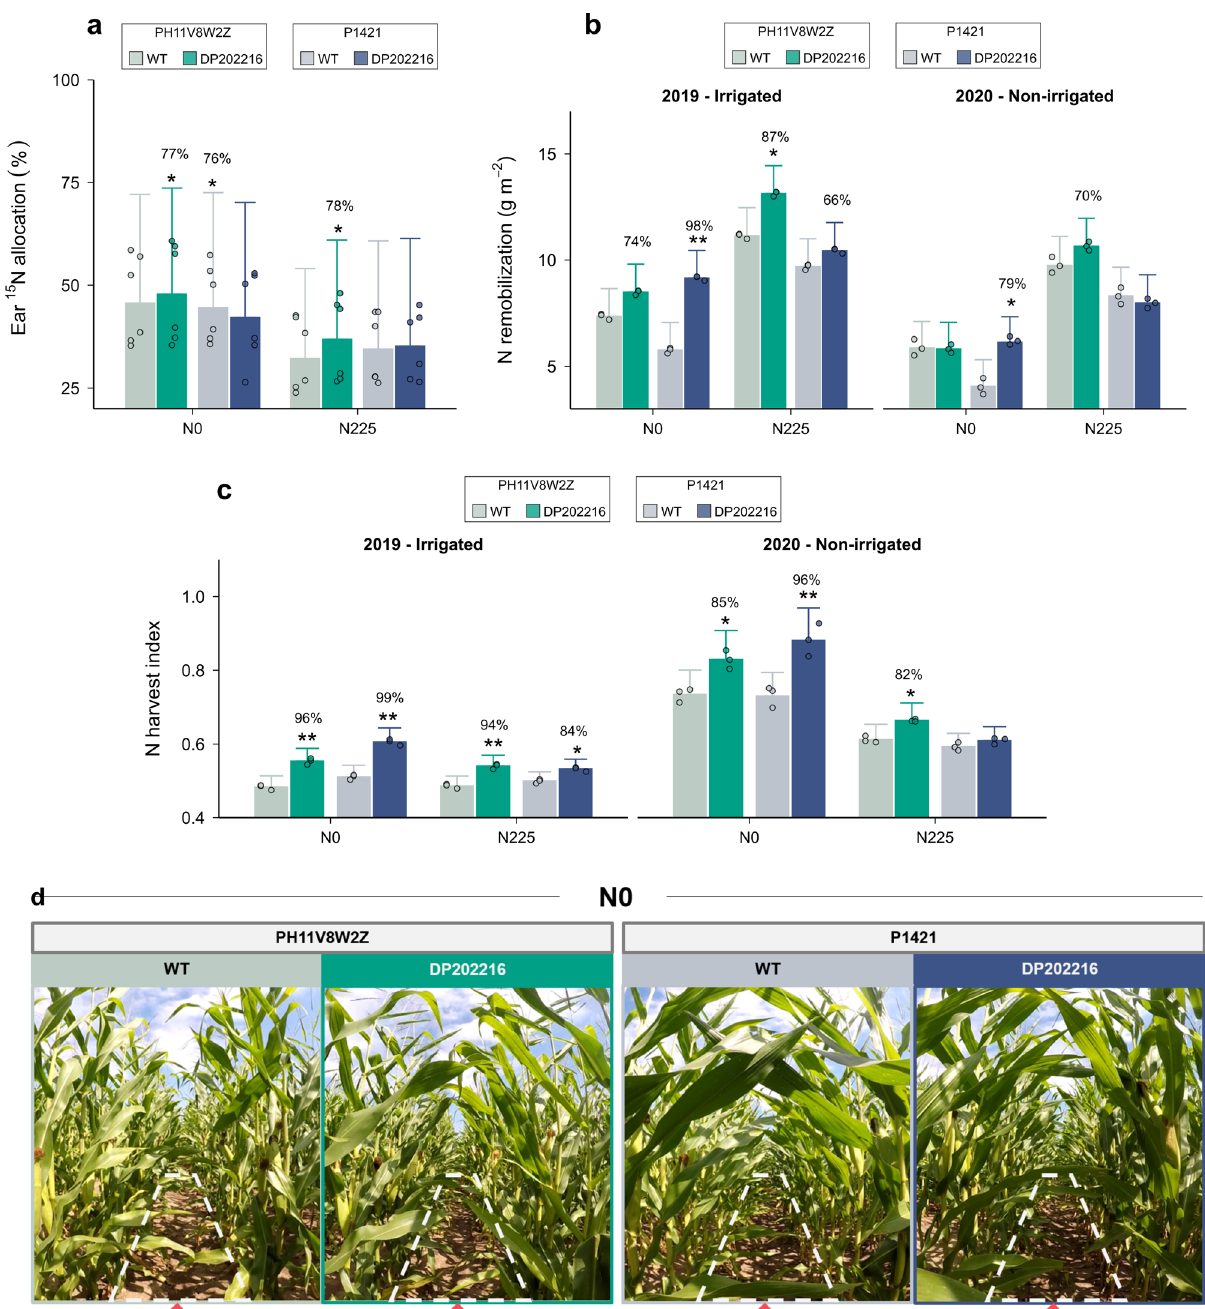
Fig. 2 Plant growth and N traits during fl owering and post- fl owering stages of WT and DP202216 fi eld-grown maize hybrids. a Proportion of 15 N that was allocated to the ear (cob + grains) during the V17-R6 period, expressed in percentage over the total 15 N uptake, for two WT and two DP202216 hybrids under 0 (N0) and 225 (N225) kg N ha − 1 conditions ( n = 3 independent samples by year). b Nitrogen remobilized to the grains from fl owering to maturity, calculated using the ‘ balance approach ’ : the difference between vegetative N at fl owering (i.e., whole-plant N at fl owering) and stover N at maturity (i.e., leaves + stem + cob + husk N fractions) ( n = 3 independent samples by year). c Nitrogen harvest index, representing the percentage of whole-plant N in the grains at maturity ( n = 3 independent samples by year). Bars and whiskers represent the medians and standard deviations of the posterior predictive distribution estimated for the two-year data in ( a ), and separated by year in b and c . Asterisks represent moderate (one) or strong (two) evidence for differences between WT and DP202216 maize hybrids. d Image of two WT and two DP202216 hybrids 15 days after fl owering under 0 kg N ha − 1 were less evident under N225. When crops were N-fertilized, NUtE were realized (medians of posterior distribution: 39 vs. there was a tendency of improvement in NUtE in transgenic 63 kg kg − 1 for 2019 and 2020, respectively). In addition, the larger response in NUtE to N rates in 2020 trials might be plants although with weak or moderate evidence for signi fi cance attributed to a greater N immobilization and lower soil N (<90% probability). On average, the effect of DP202216 was more mineralization rates derived from wheat residues, although no markedly for the 2019 fi eld experiment when lower levels of